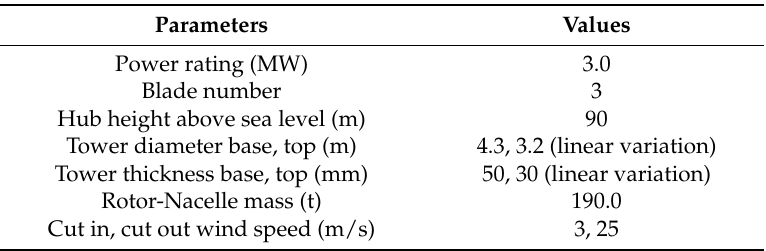
Figure 9. Composite bucket foundation in Xiangshui Wind Farm: ( a ) Location of Xiangshui Wind Farm; ( b ) Composite bucket foundation. Table 3. Parameters of the 3.0 MW OWT.